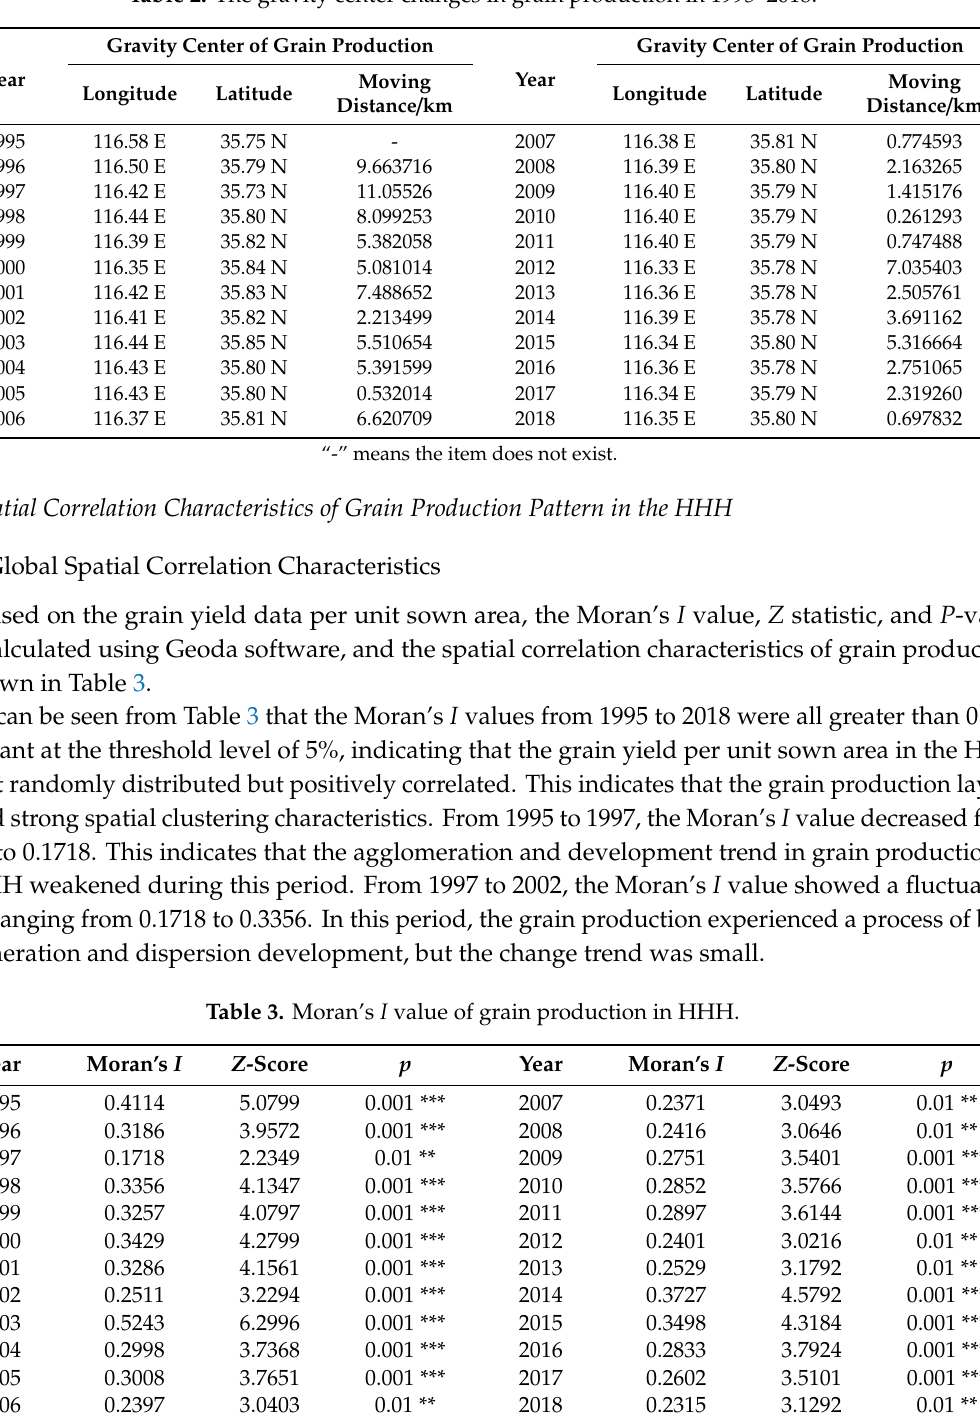
Table 2. The gravity center changes in grain production in 1995–2018.